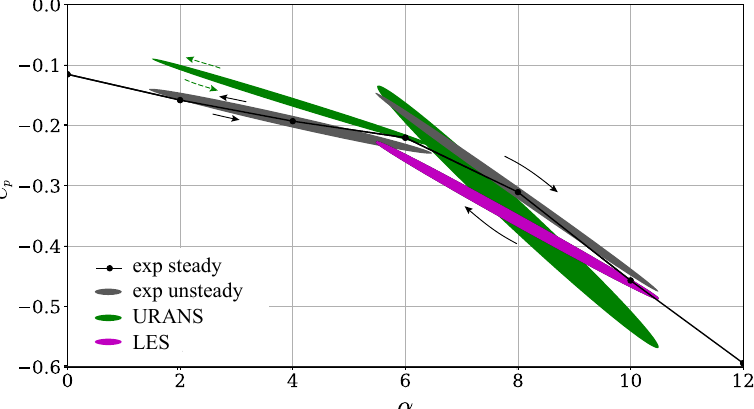
Figure 11. Comparison of steady and unsteady pressure coefficients measured at x / c = 0.20 and filtered at k = 0.12 for difference incidence